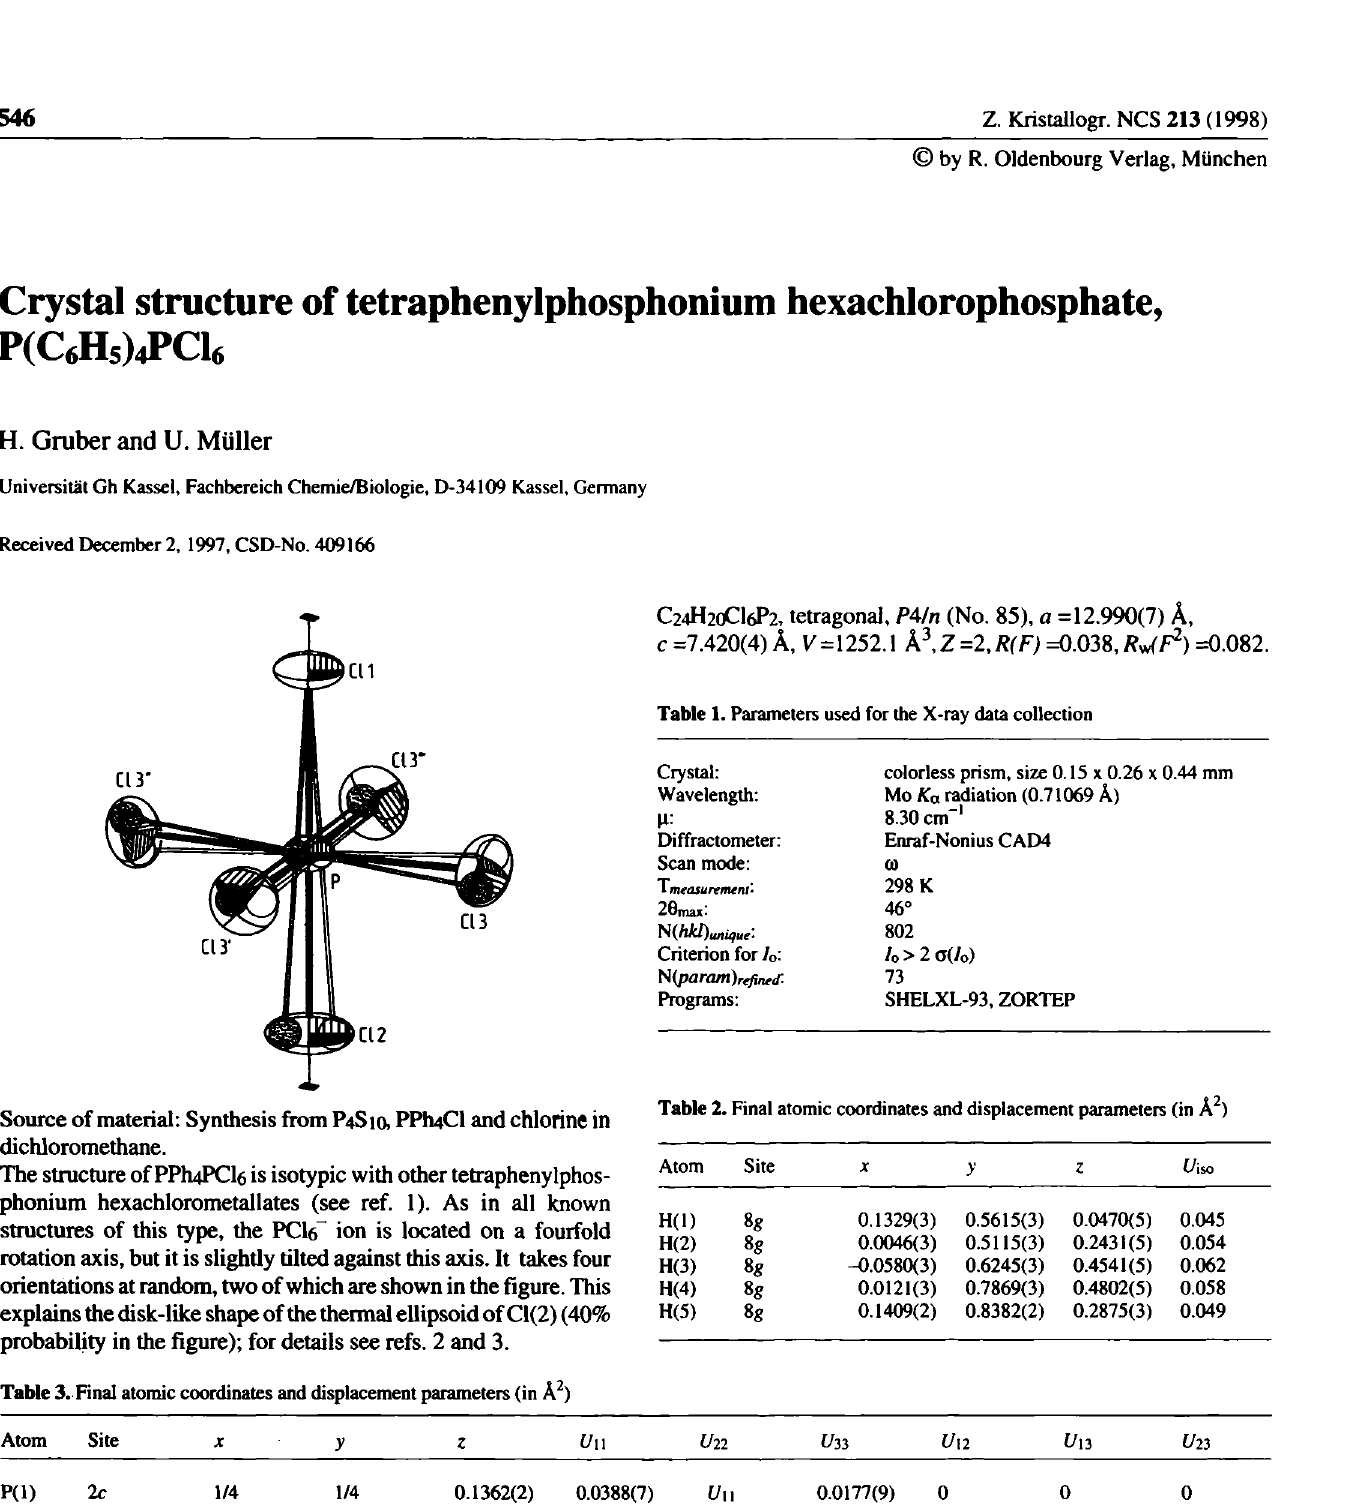
Table 3. Final atomic coordinates and displacement parameters (in Â^)